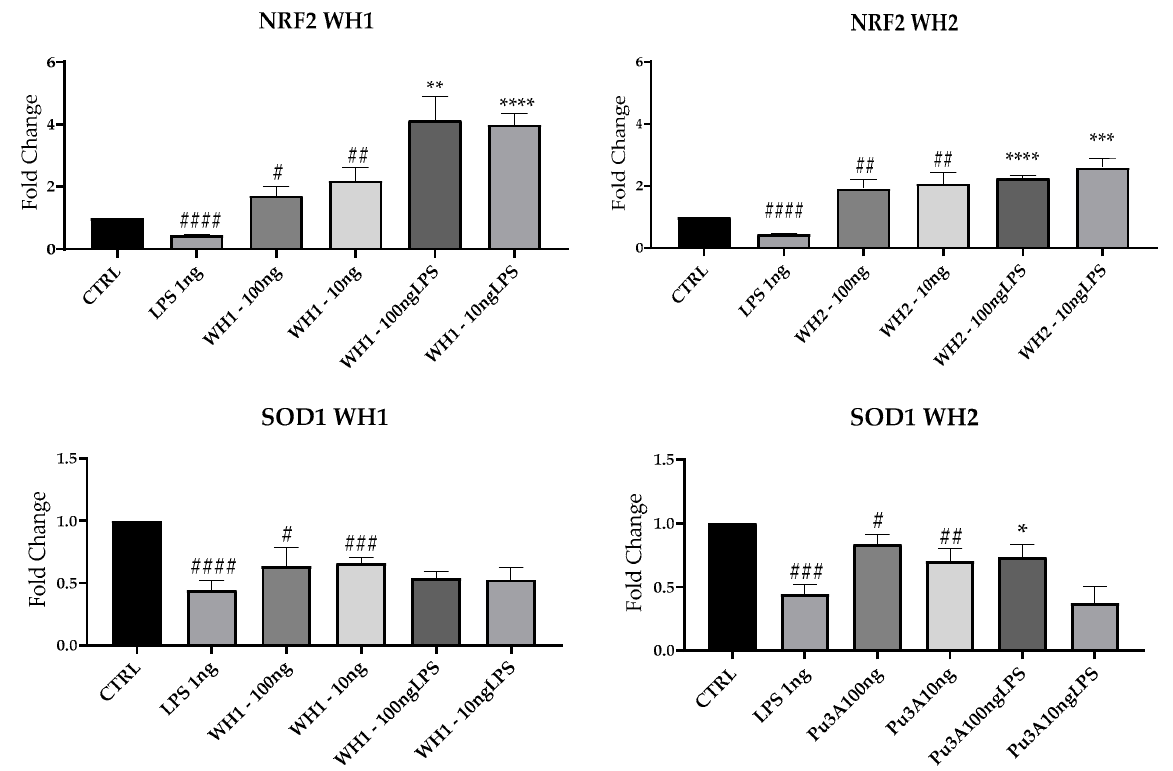
Figure 7. NRF2 and SOD1 mRNAs were evaluated by qRT-PCR. Data are shown as mean ± SD from three independent experiments performed in triplicate. Expression profiles were determined using the 2 −ΔΔ CT method. # VS CTRL; * VS LPS; * p < 0.05; ** p < 0.01; *** p < 0.001; **** p < 0.0001; # p < 0.05; ## p < 0.01; ### p < 0.001; #### p < 0.0001.